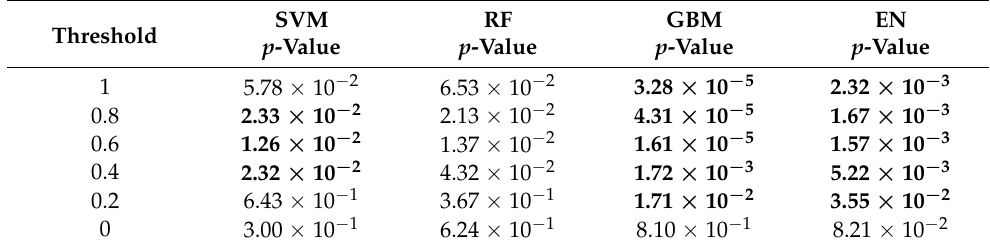
Table 2. Enrichment test of the predicted targets for DM.